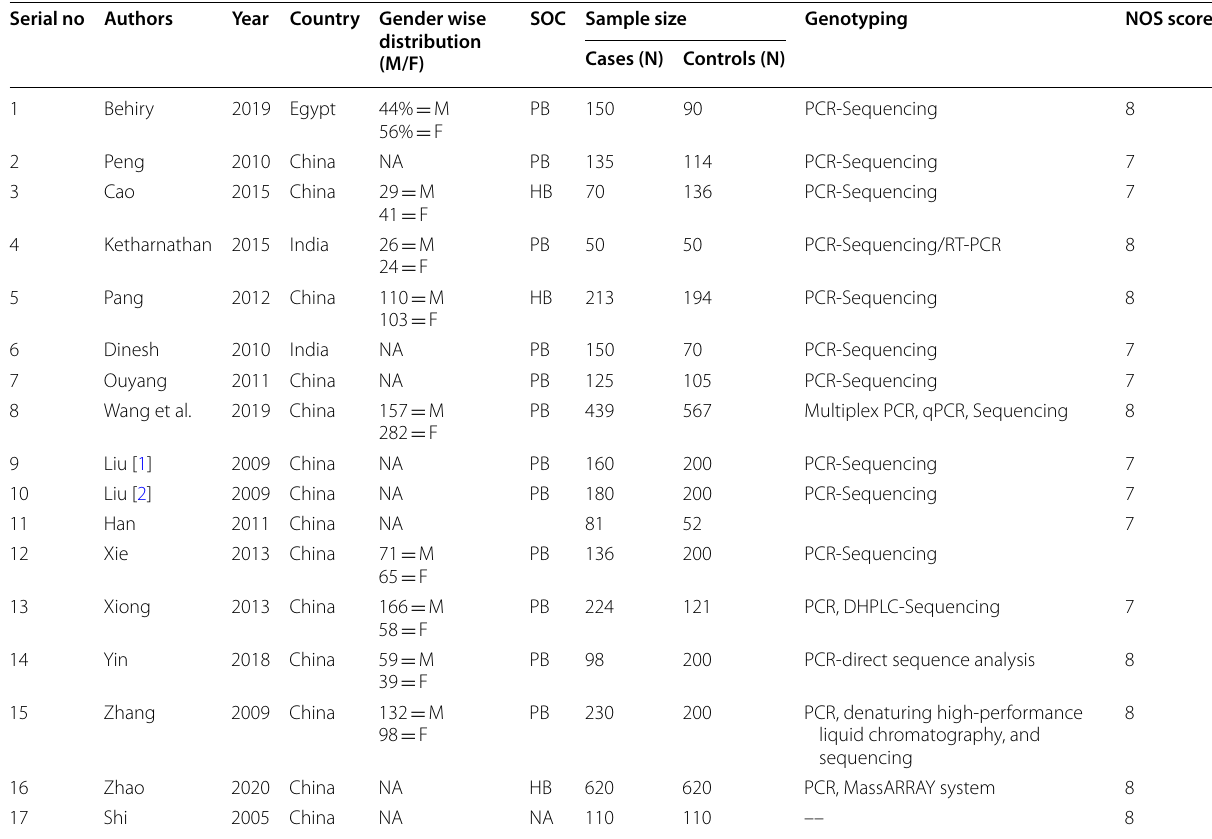
Table 1 Characteristics of each study included in the final analysis